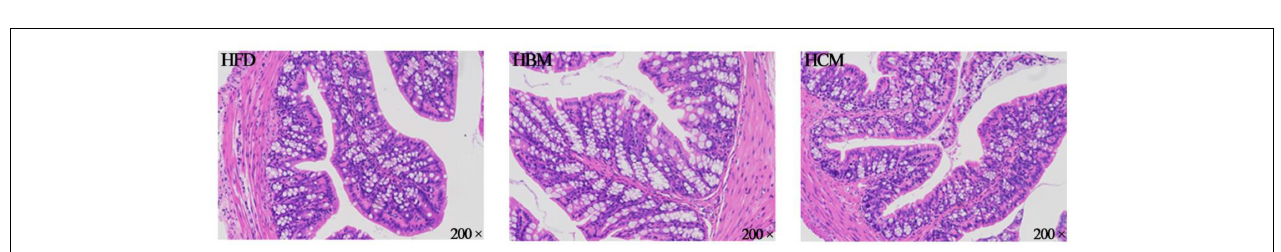
FIGURE 3 | Effects of buffalo and cow milk on hepatic lipid accumulation in mice fed by high fat diet. (A) H & E staining of the liver tissues from representative mice of each group (200 × ); (B) oil red O staining of the liver tissues from representative mice of each group (200 × ); (C) calculated value for lipid area of (A) ; (D) calculated value for lipid area of (B) .